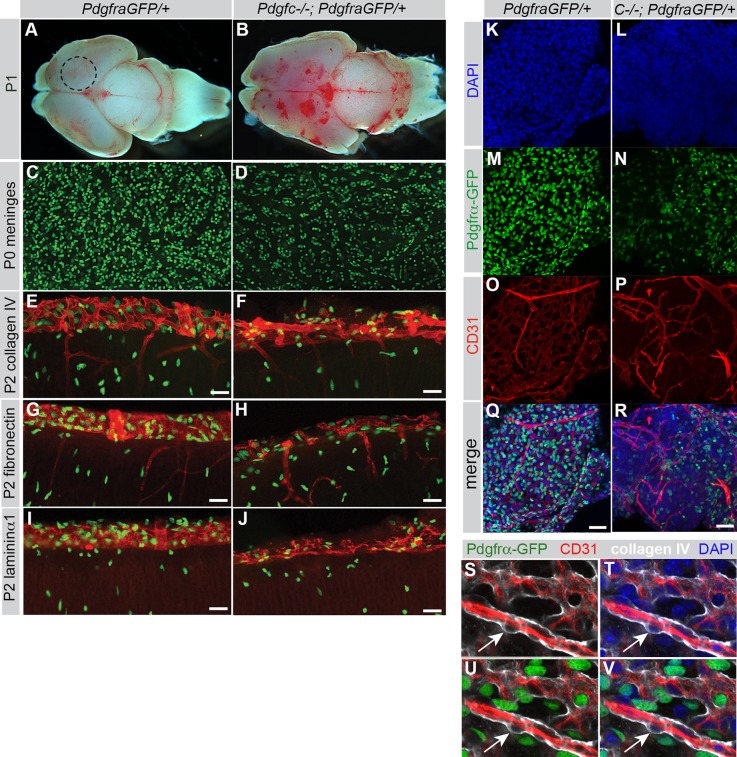
Structural changes in cerebral meninges of Pdgfc−/−; PdgfraGFP/+ mice. (A) Dorsal view of P1 brain from PdgfraGFP/+ mouse. Dotted circle indicates area for dissection of meninges. (B) Irregular shape and bleedings in brain from P1 Pdgfc−/−; PdgfraGFP/+ mouse. (C) Meninges peeled off from the dorsal, cerebral hemisphere of newborn PdgfraGFP/+ mice, dotted circle in A. (D) Reduced numbers of PDGFRα-positive cells in Pdgfc−/−; PdgfraGFP/+ meninges. (E-J) Immunofluorescent staining for extracellular matrix proteins Collagen IV (E,F), Fibronectin (G,H) and Laminin α1 (I,J) in coronal sections through the cerebral cortex in P2 pups show an irregular structure of the meninges in Pdgfc−/−; PdgfraGFP/+ mice. (K-R) Extended view of confocal z-stack of P4 meninges, PdgfraGFP/+ (left column) and Pdgfc−/−; PdgfraGFP/+ (right column). (K,L) DAPI. (M,N) Fewer PDGFRα-GFP-positive cells in mutants. (O,P) CD31 reveal variations in the vascular network. (Q,R) Merged view. (S-V) Pdgfra expression in non-vascular meningeal cells. Cerebral meninges from PdgfraGFP/+ brain immunostained for CD31 (red) and collagen IV (white). Arrow points at a PDGFRα negative vascular cell. Scale bars: 50 µm in E-J, 40 µm in K-R.